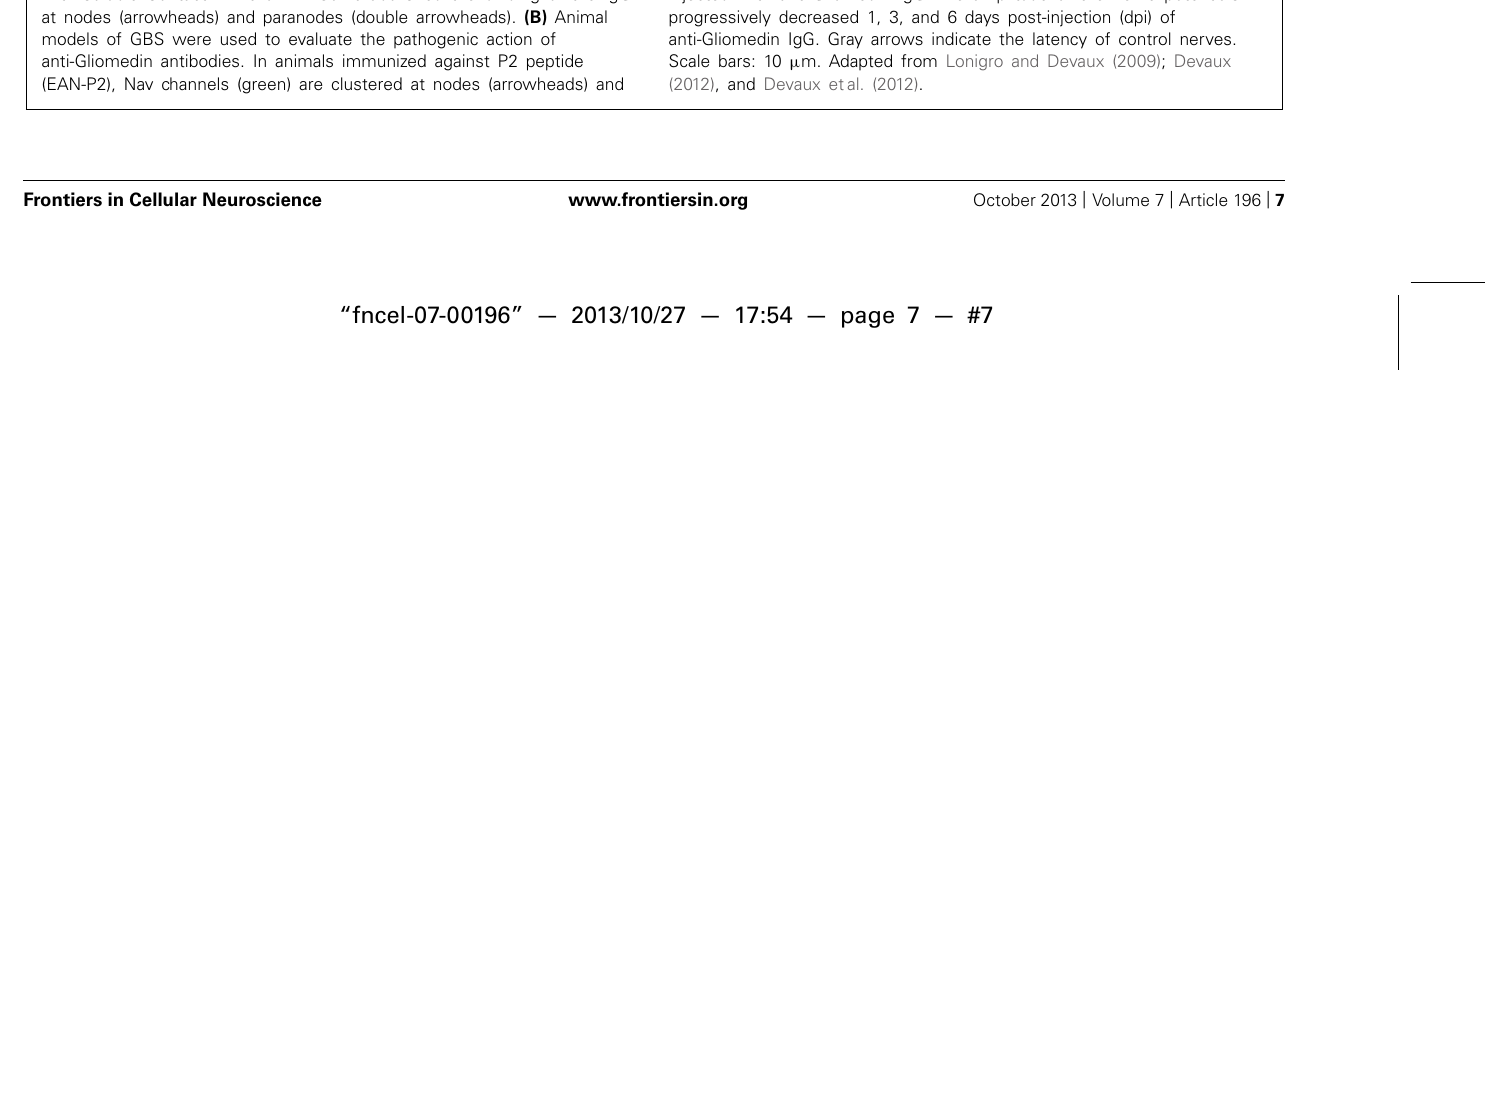
FIGURE 3 |Antibodies target nodal CAMs in GBS patients and animal models. (A) Mouse sciatic nerve fibers were incubated with sera (green) from AIDP (left panels) or AMAN (right panels) patients which are reactive against Contactin-1 and Neurofascin, respectively. Fibers were stained for Caspr (red) to label the paranodes. Pre-incubation of the sera with soluble Contactin-1-Fc or NF186-Fc abolished the binding of the IgG at nodes (arrowheads) and paranodes (double arrowheads). (B) Animal models of GBS were used to evaluate the pathogenic action of anti-Gliomedin antibodies. In animals immunized against P2 peptide (EAN-P2), Nav channels (green) are clustered at nodes (arrowheads) and